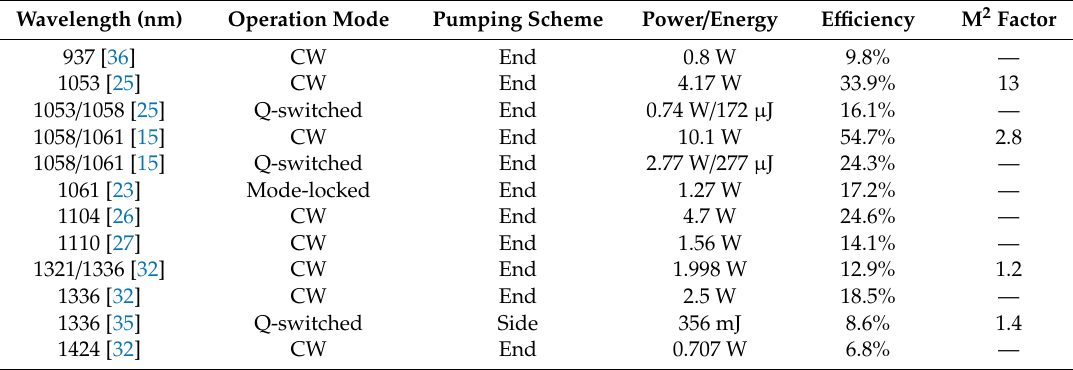
Table 2. Laser performance at major oscillating wavelengths of Nd:GYSGG.